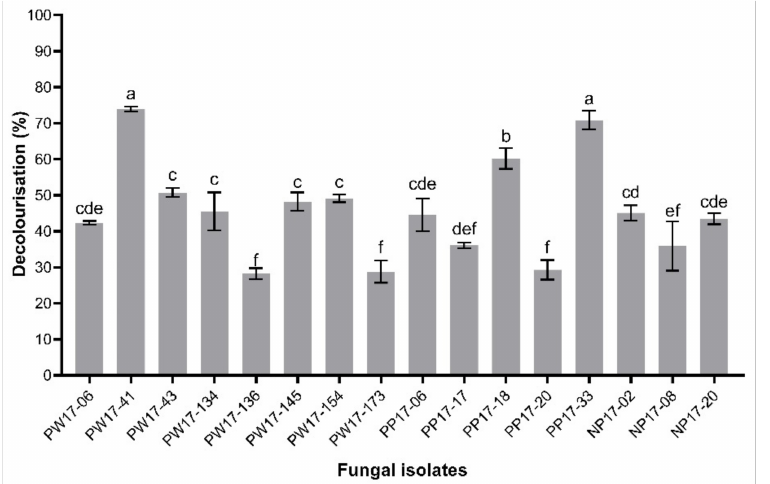
Figure 1. Ability of different white-rot fungi for textile dye decolourisation under submerged conditions. Error bars indicate the standard deviation, while letters a–f indicate statistically significant differences between groups analysed via one-way ANOVA ( n = 3, p <